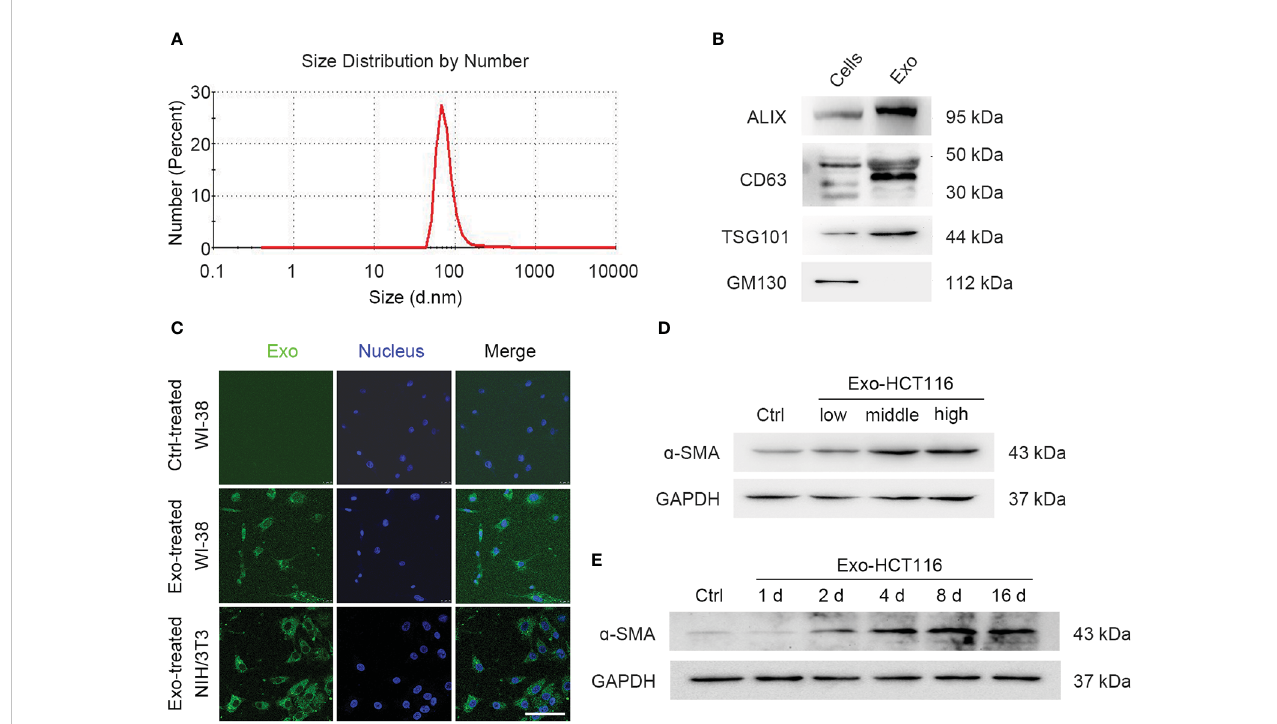
FIGURE 1 Exosomes from CRCs were uptaken into fi broblasts. (A) Zetasizer nanoparticle size analysis shows the particle size from HCT116 cells. (B) Western blot analysis shows exosomal biomarkers. Exosomal speci fi c markers: TSG101, CD63, and Alix; Cell-speci fi c marker: GM130. (C) Confocal microscope images show fi broblast uptake of PKH67-labeled exosomes for 24 h. Scale bar, 100 m m. (D) Western blot analysis shows the a -SMA expression under the treatment of exosomes of series concentrations (low, middle, and high concentration represent 0.3, 3, and 30 m g/ml, separately). (E) Western blot analysis shows the a -SMA expression under the treatment of exosomes during a period